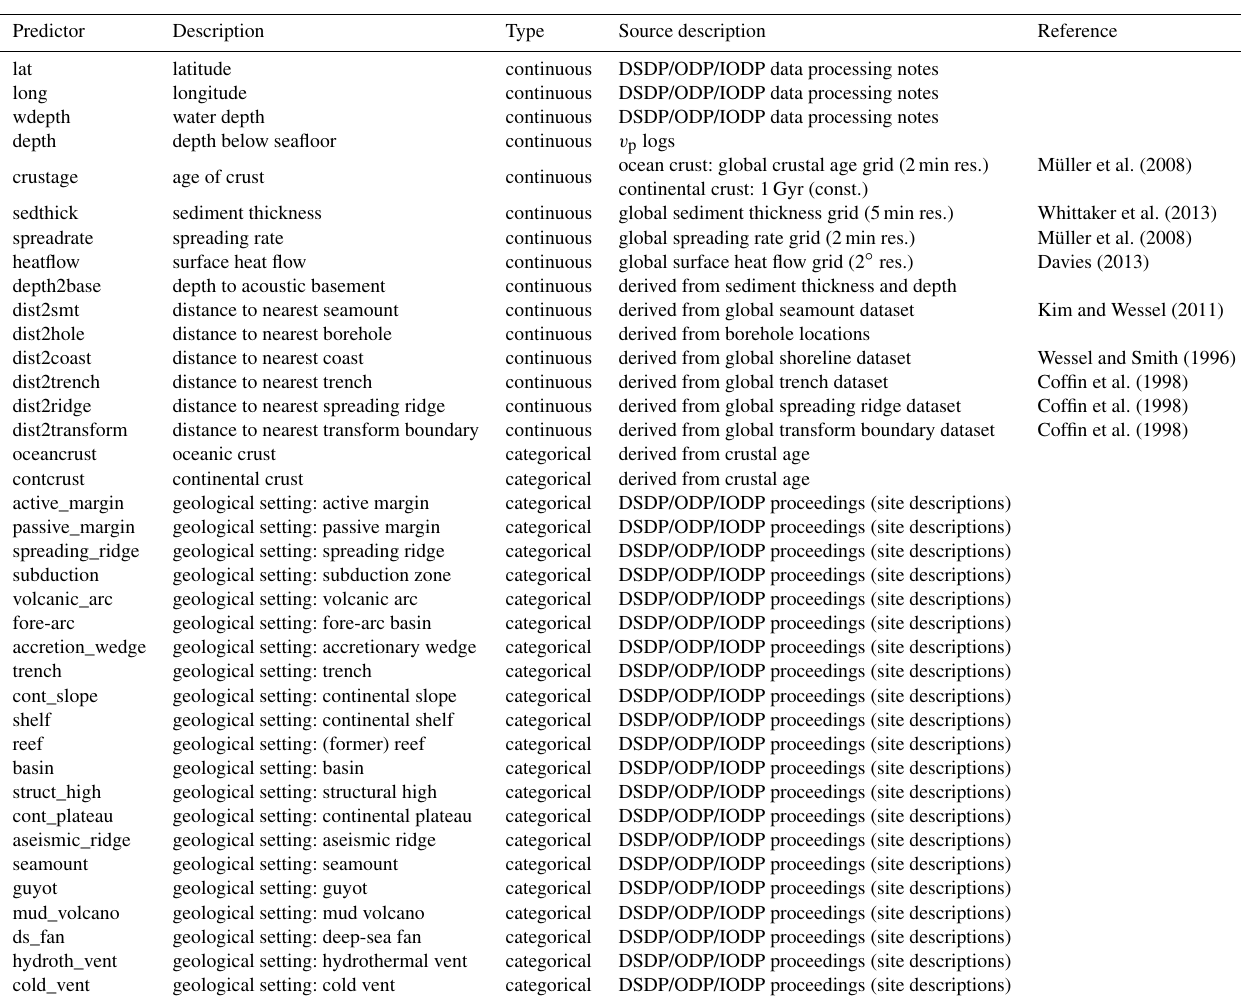
Table 1. Overview of the 38 predictors and their sources.